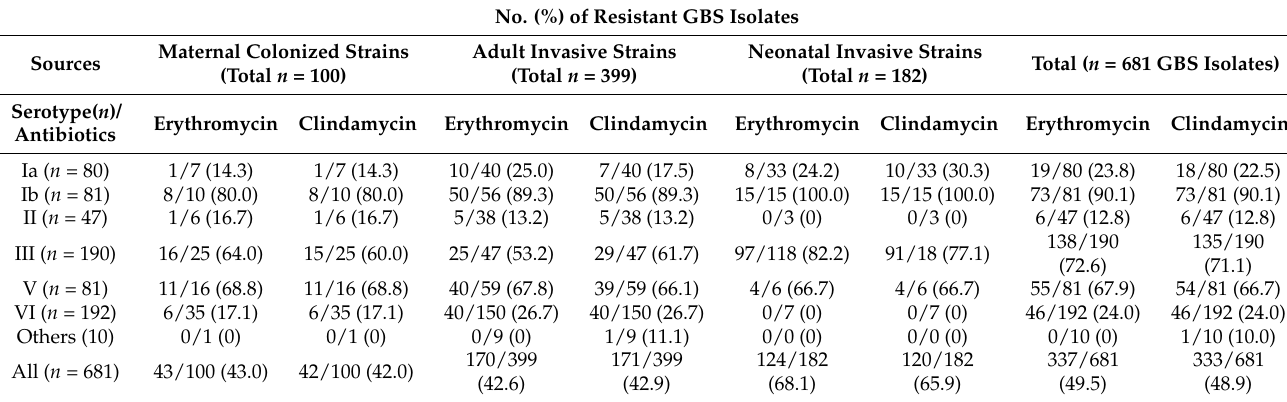
Table 2. Serotype distributions and antibiotic resistance of 681 GBS isolates from maternal colonization, neonatal and adult invasive diseases.